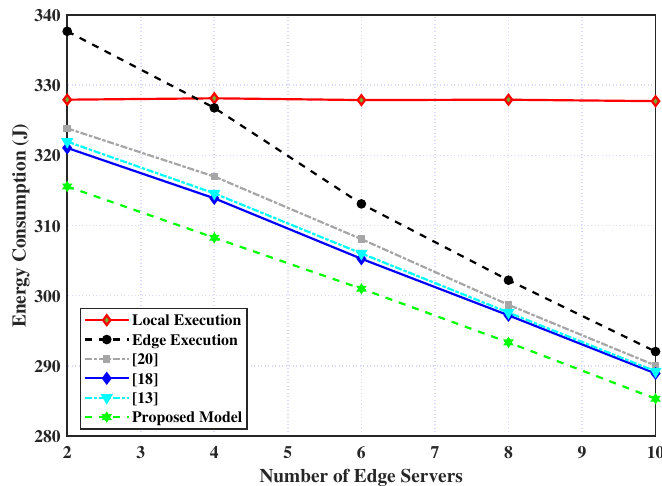
Figure 7. Energy consumption over number of edge